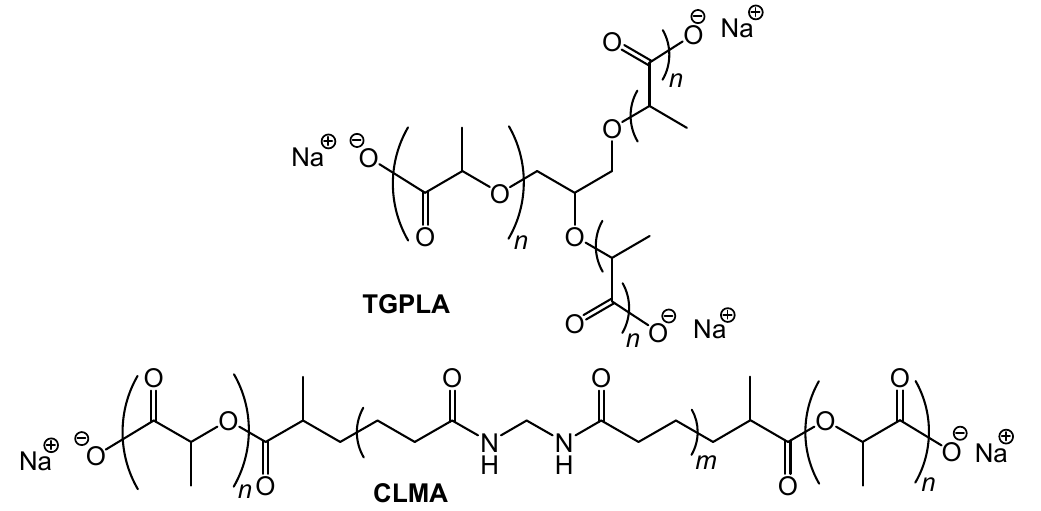
Figure 2. Chemical structures of triglyceride polylactic acid (TGPLA) and carboxy lactic methacrylate (CLMA) synthetic thickeners.